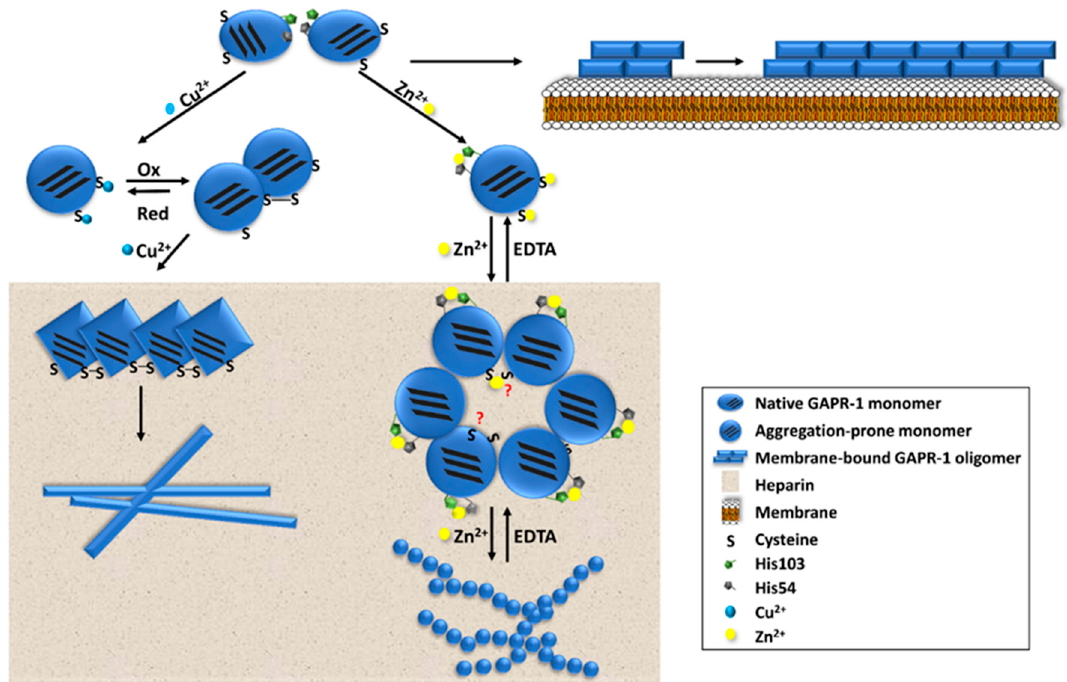
Figure 2. Hypothetical model for GAPR-1 amyloid-like aggregation. GAPR-1 binding to membranes undergoes a structural rearrangement and a concentration step, resulting in protein amyloid fibrillation [157,168]. Both zinc and copper ions binding modulate the quaternary structure of GAPR-1, shifting native multimers to monomers. Zn 2+ induced aggregation pathway is dependent on the proposed metal binding site within GAPR-1, including His54 and His103, and independent of redox conditions. Zn 2+ modulated GAPR-1 assembly is reversible by chelating zinc ions, which reversibly regulates the cysteine accessibility in GAPR-1. Disulfide bond formation is crucial for the initiation of Cu 2+ induced aggregation pathway. Cu 2+ regulated GAPR-1 self-association is irreversible and independent of the suggested metal binding site. Heparin acts as a scaffold on which GAPR-1 is concentrated and oriented to promote protein assembly [155,156].